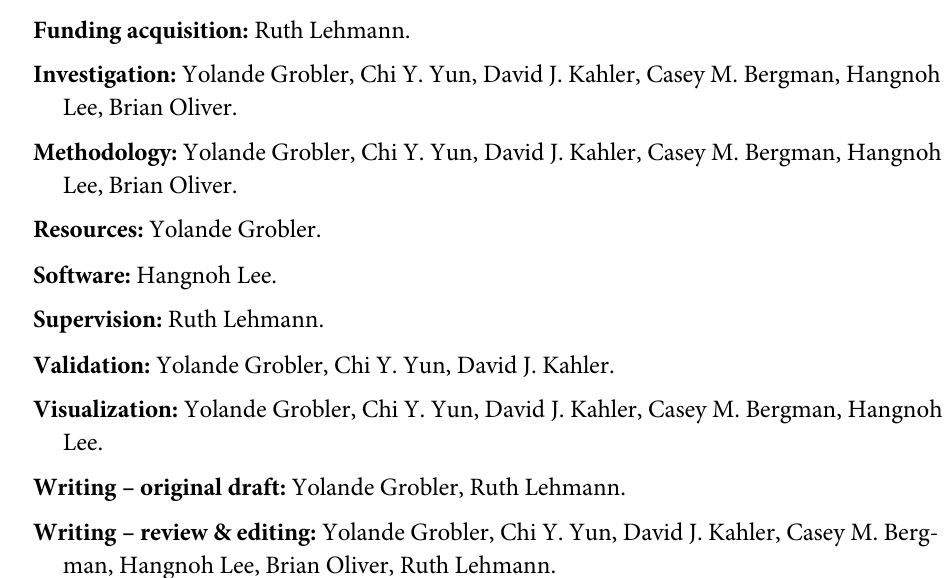
S5 Table. List of genes with amplicons that hit in the screen but were excluded for no gene expression in RNAseq dataset. S6 Table. 1117 gene hits from whole genome RNAi screen. S7 Table. Hit dsRNA amplicons comparison of changes in Wolbachia levels and changes in cell